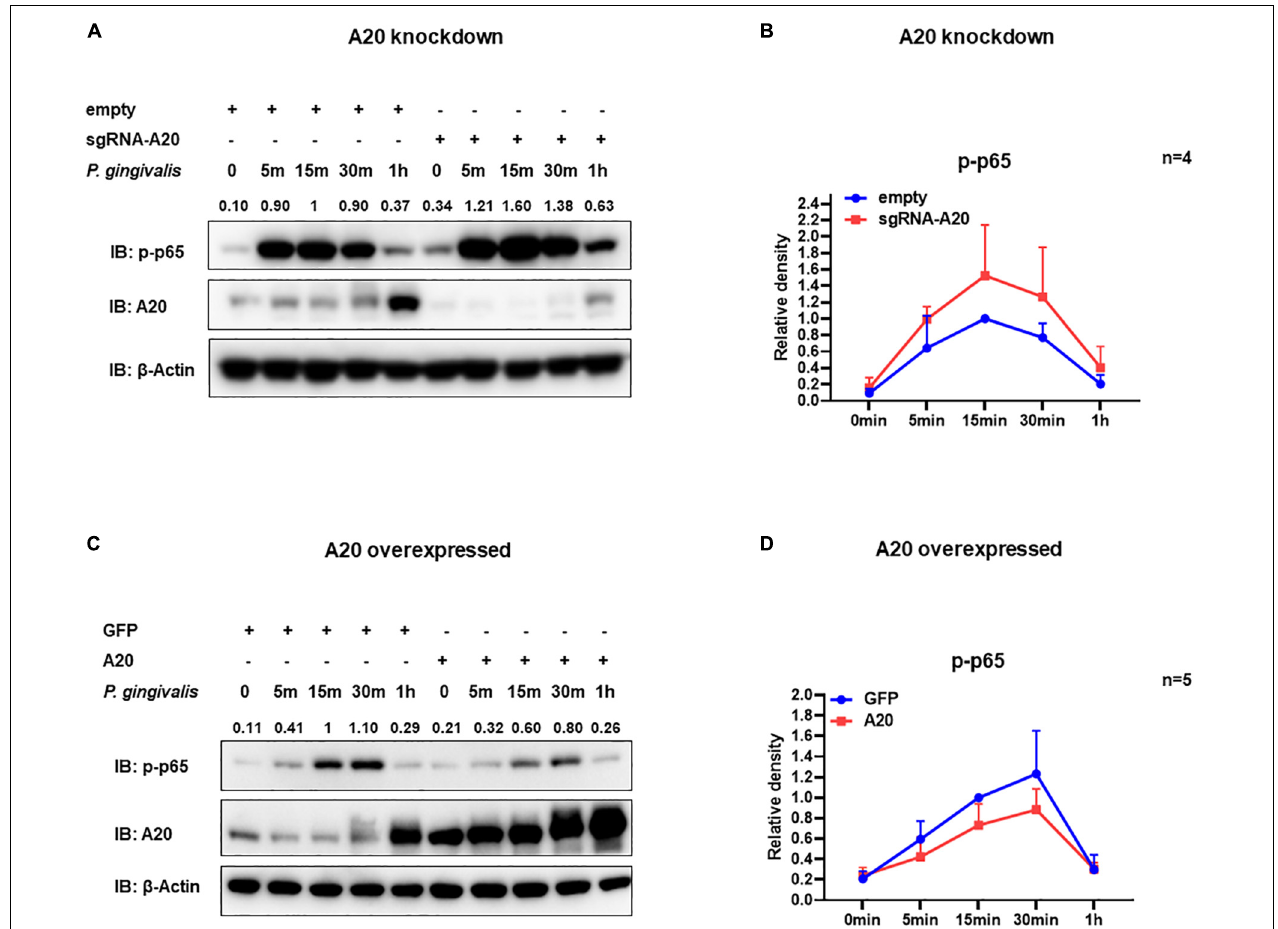
FIGURE 6 | A20 diminishes p65 phosphorylation in TIGKs infected with P. gingivalis . Western blots detecting phosphorylated p65 (p-p65) in TIGKs with altered A20 expression or control cells with P. gingivalis infection. Representative blots of p-p65 in TIGKs or TIGKs with A20 knock-down (A) or A20 over-expression (C) with P. gingivalis (100 MOI) for indicated time points and the levels for indicated proteins were blotted. Relative density of p-p65 levels from four or five independent experiments were plotted with as mean and standard errors (B,D)